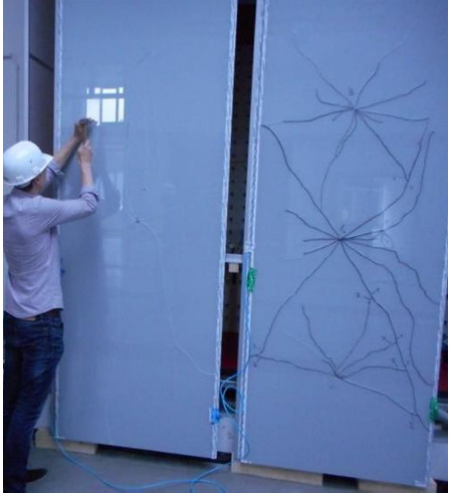
Fig. 11 Breakage pattern of heat-strengthened glass ply bonded to a sandwich